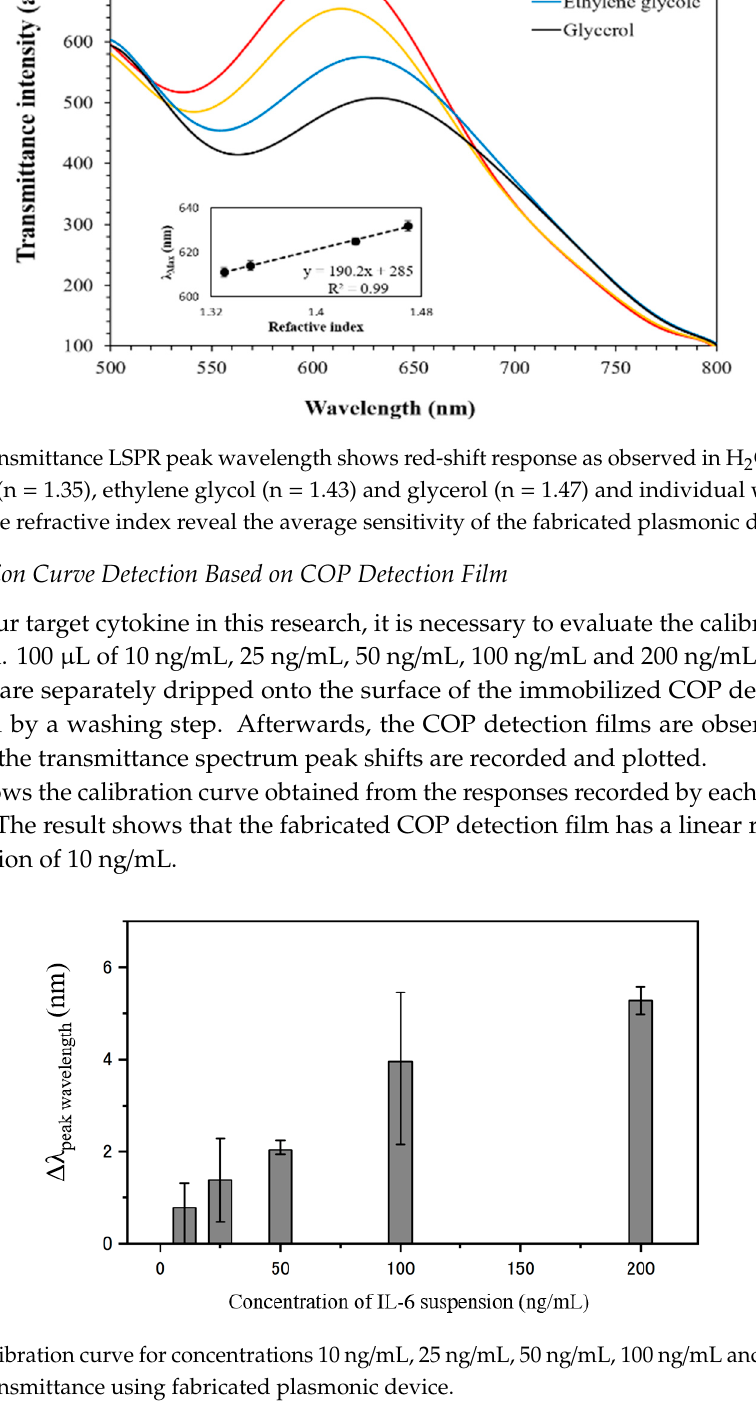
Figure 2. Transmittance LSPR peak wavelength shows red-shift response as observed in H 2 O (n = 1.33), 1 M glucose (n = 1.35), ethylene glycol (n = 1.43) and glycerol (n = 1.47) and individual wavelength shifts over the refractive index reveal the average sensitivity of the fabricated plasmonic device.